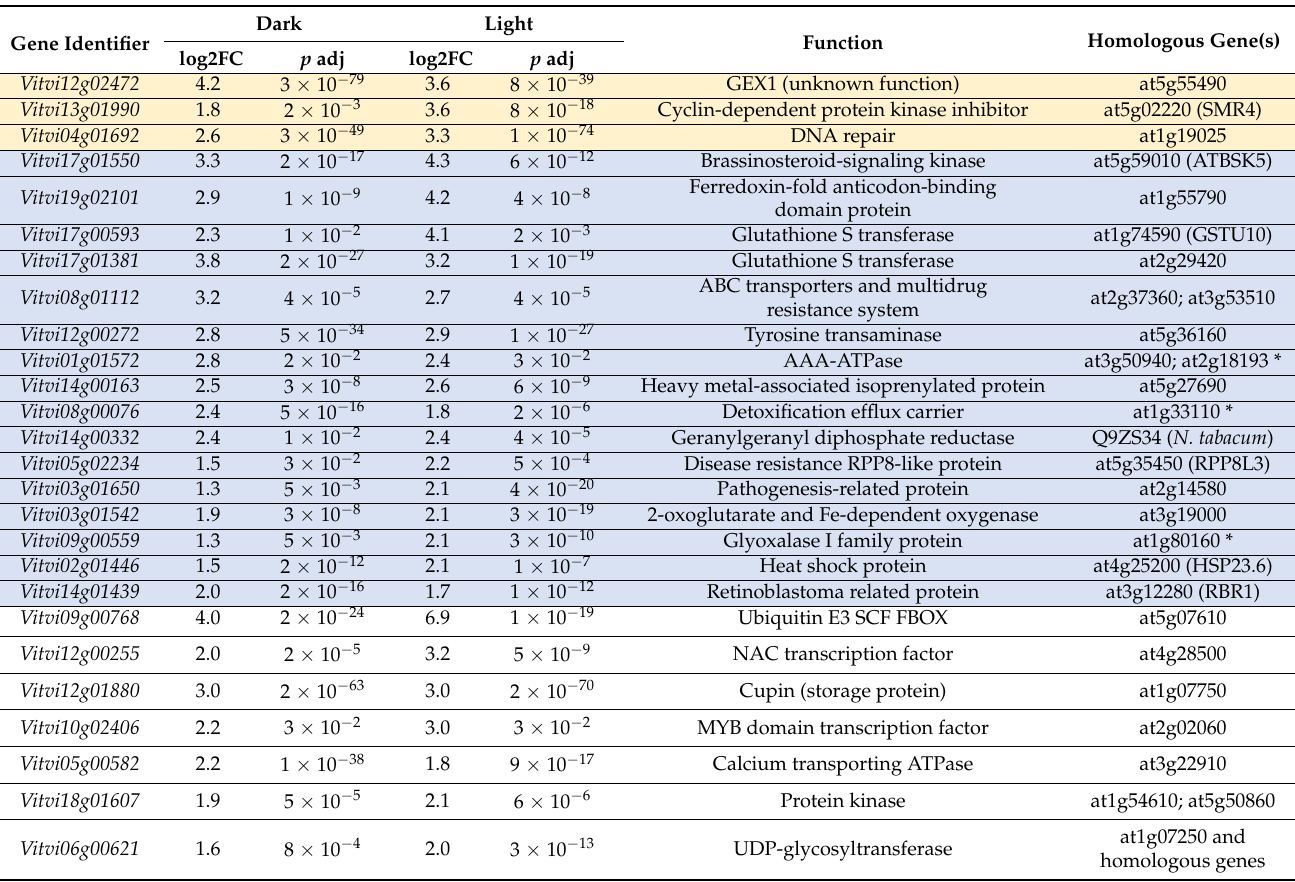
Table 1. Genes up-regulated by zebularine both in light and dark grown cells. A number of 68 DEGS were identified as specifically up-regulated by zebularine in the light and in the dark with a log2-fold change (log2 FC) > 1 and an adjusted p -value ( p adj) > 0.05. Among them, 38 genes were associated with a log2 FC > 2 at least in one comparison (DL versus DZ50 or LD versus LZ50). Finally, a putative function could be assigned for 26 of these 38 genes, by comparison with homologous genes found in Arabidopsis thaliana or Nicotiana tabacum ( N. tabacum ) genomes. The orange color indicates genes related to genotoxic stress and/or DNA repair processes. The blue color indicates stress-related genes. * indicated Arabidopsis thaliana genes induced by atrazine [93].